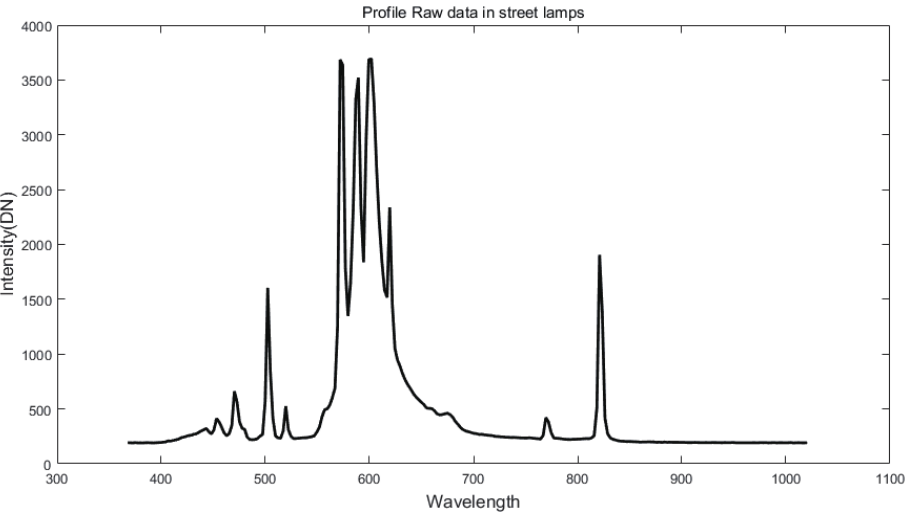
Figure 4. Spectral profile of a